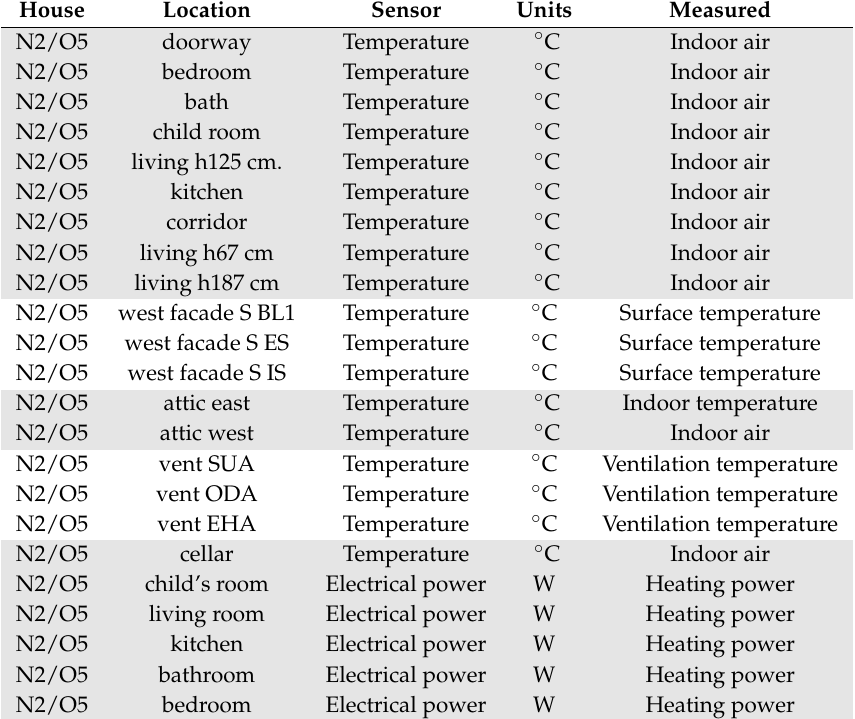
Table 1. Sensors provided by the Annex 58 experiment. Grey indicates the sensors